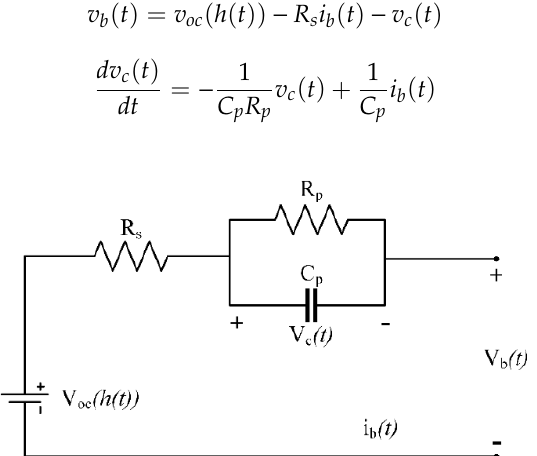
Figure 26. Equivalent circuit model of the Li-ion battery, consisting of a resistor in series with an RC parallel branch and a voltage source [92].